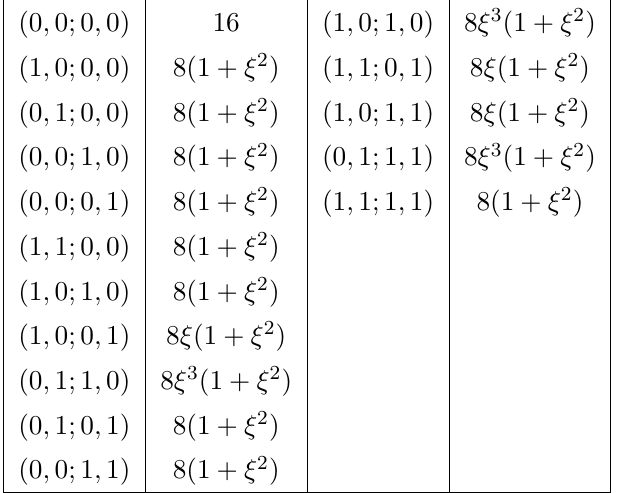
Table 3 . Multiplicities and phases of effective Z 2 × Z 2 twisted sectors in Z 4 × Z 4 orbifold with discrete